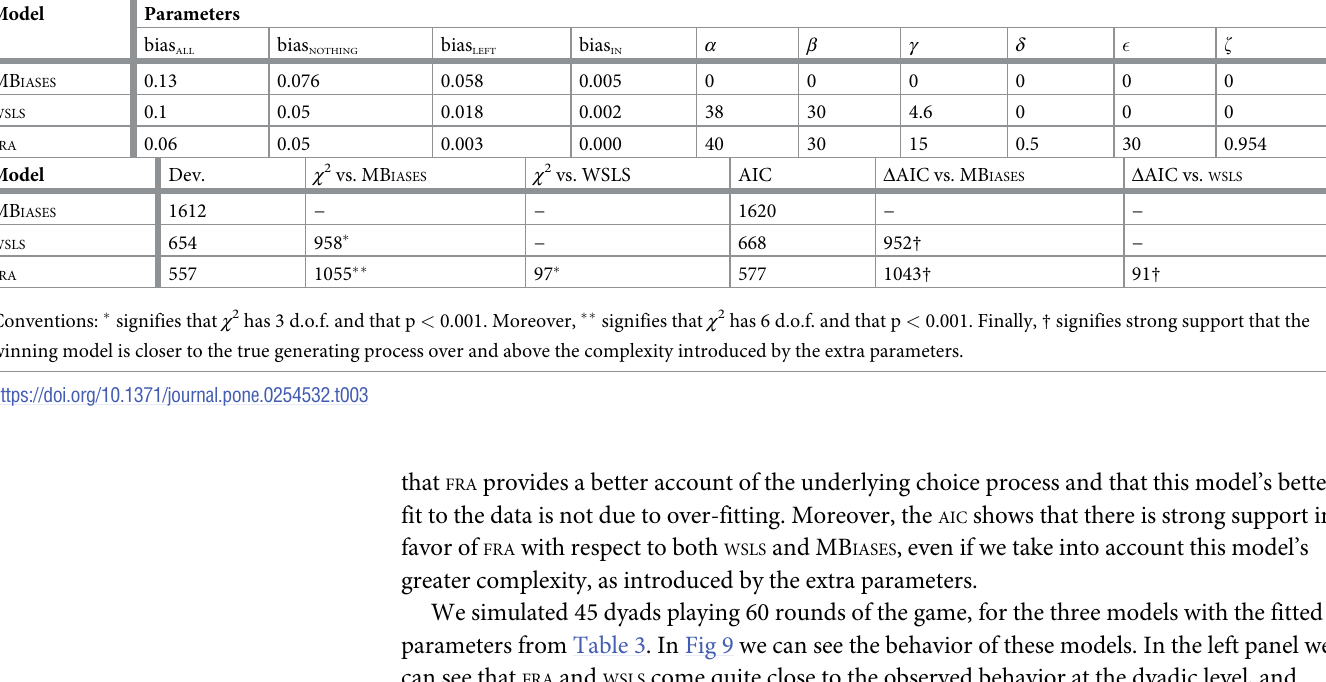
Table 3. Best parameters, deviance, and AIC for each model. It also presents the critical value of χ 2 for the Likelihood Ratio Test for nested models. Model Parameters